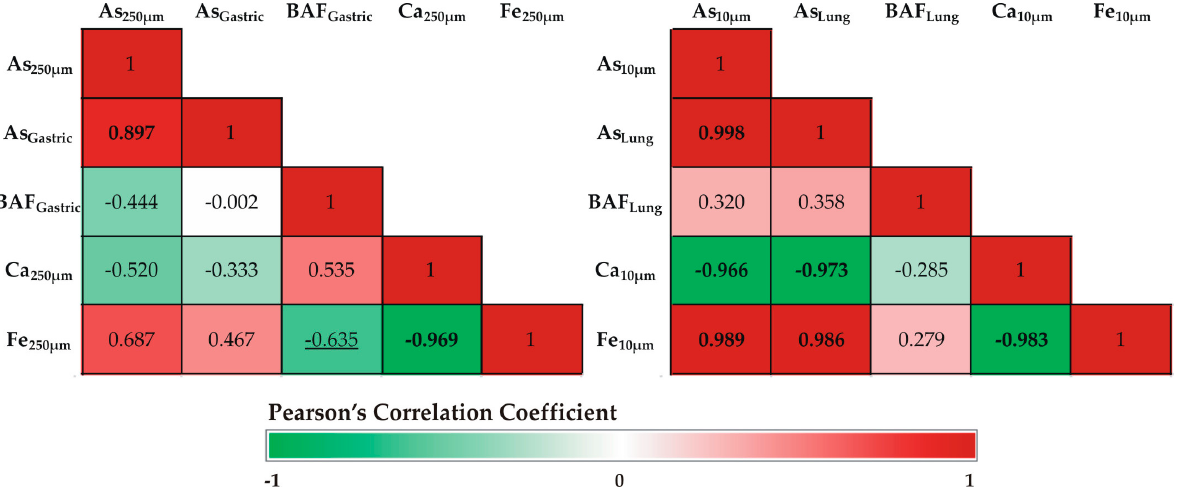
Figure 6. Heat maps of Pearson’s correlation coefficients matrix for ( left ) gastric and ( right ) lung As bioaccessibility and selected geochemical parameters. Correlations in red are positive and in green are negative. p < 0.01 significance is marked in bold, and p < 0.05 in underlined.